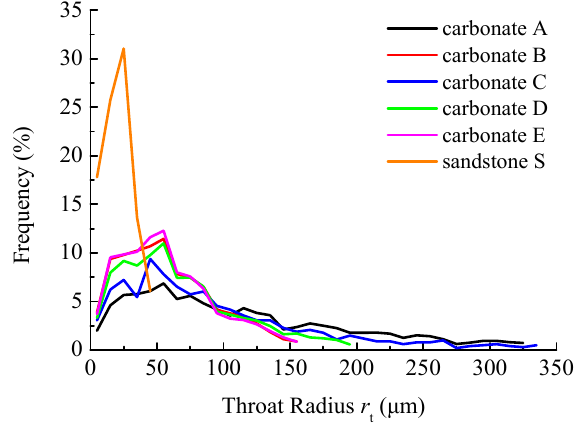
D and E), respectively.